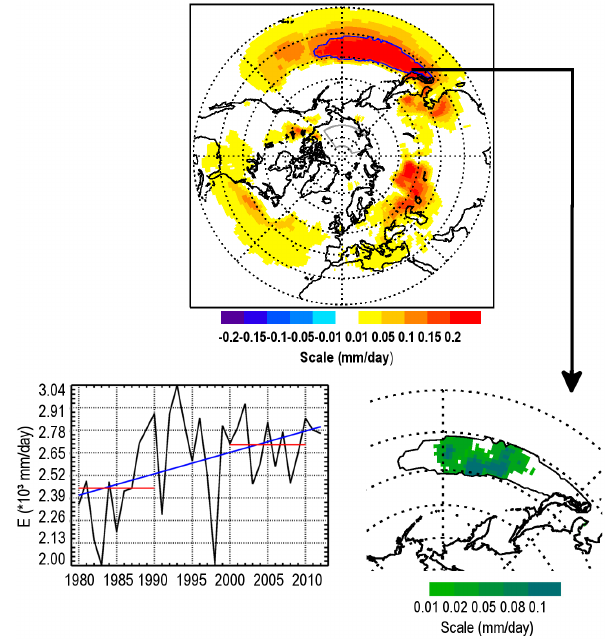
Figure 2. As Fig. 1 but for the Kapsch area (75–85 ◦ N, 115– 215 ◦ E), denoted with the grey contour in the bottom